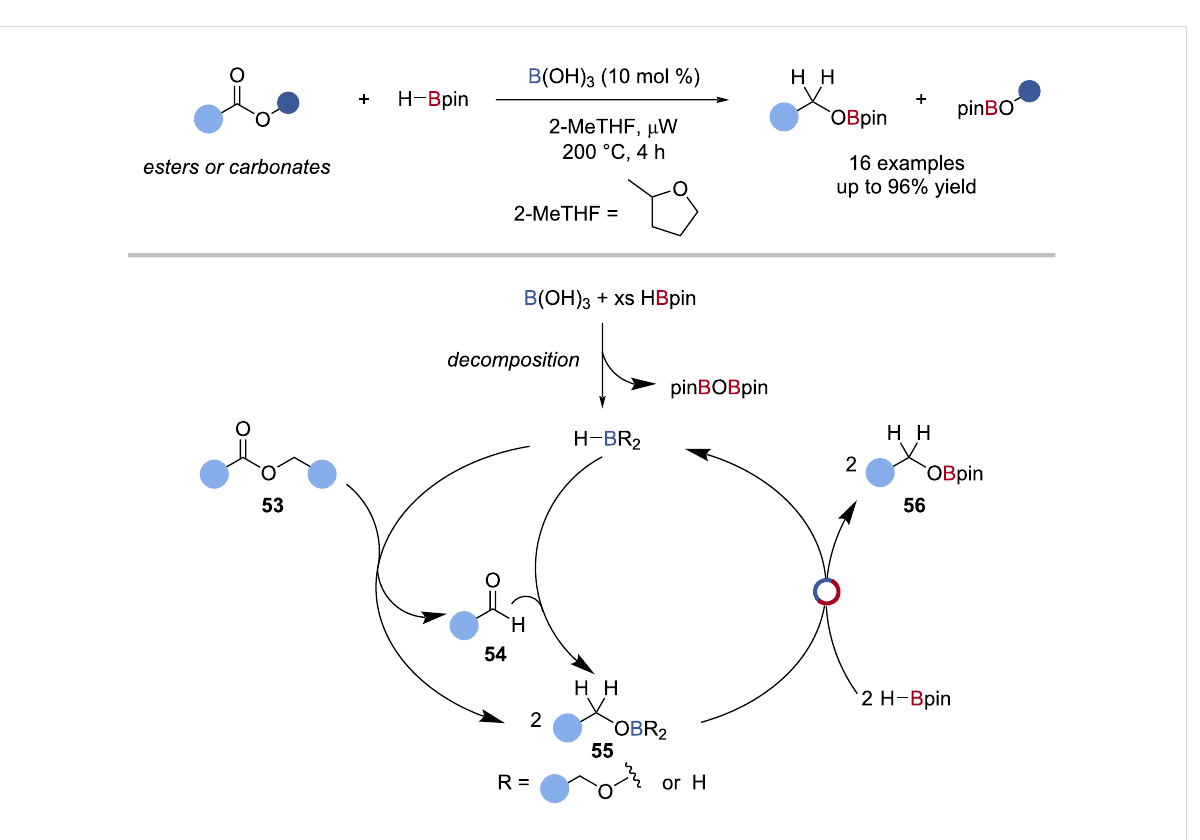
Scheme 13: Boric acid-promoted reduction of esters, lactones, and carbonates and the proposed